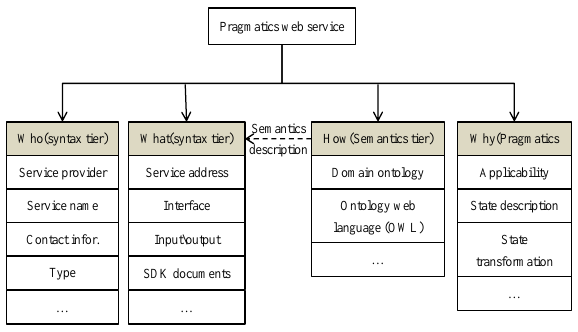
Figure 2. Conceptual model of pragmatics web